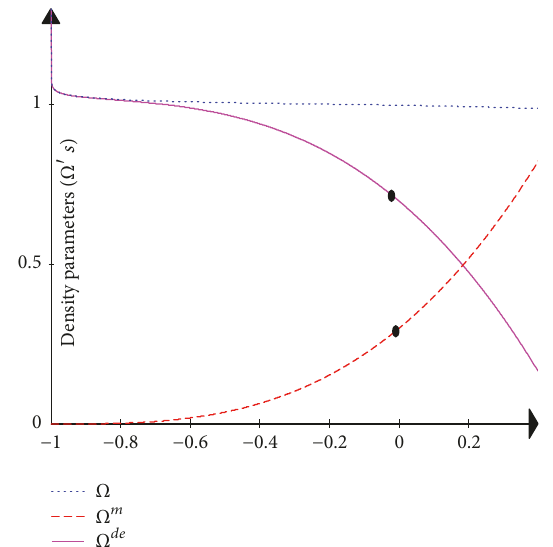
Figure 2: The plot of total energy densities versus redshift 𝑧 for 𝛼 = 1 , 𝛽 = 0.01, Ω 𝑚 = 0.3 , 𝜔 𝑚 = 0 , 𝜔 = 2 , and 𝐾 = 0.01 . 0